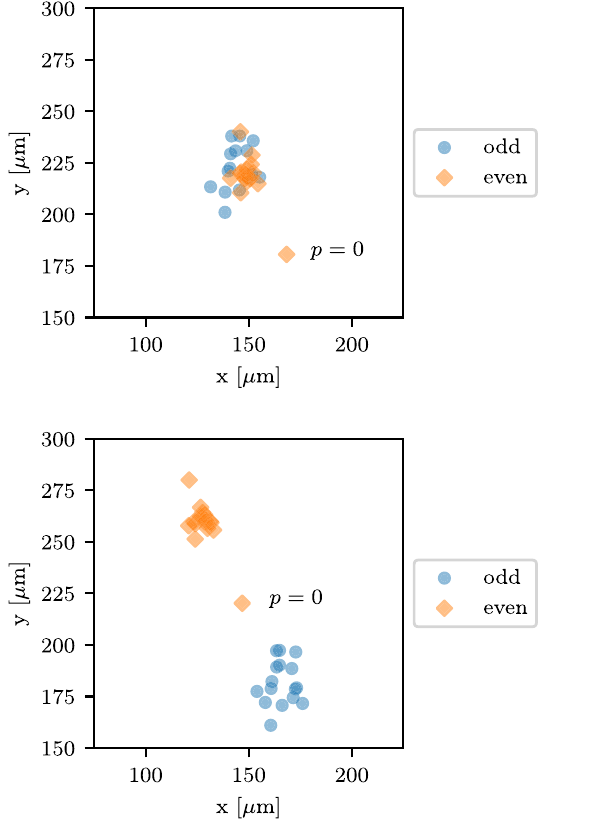
FIG. 29. Top: Experimental circulation pattern after the MPS1 steering in-situ . Bottom: Experimental circulation pattern after the fast optimization of the M2 parabola, RX , RY and injection of the beam in the